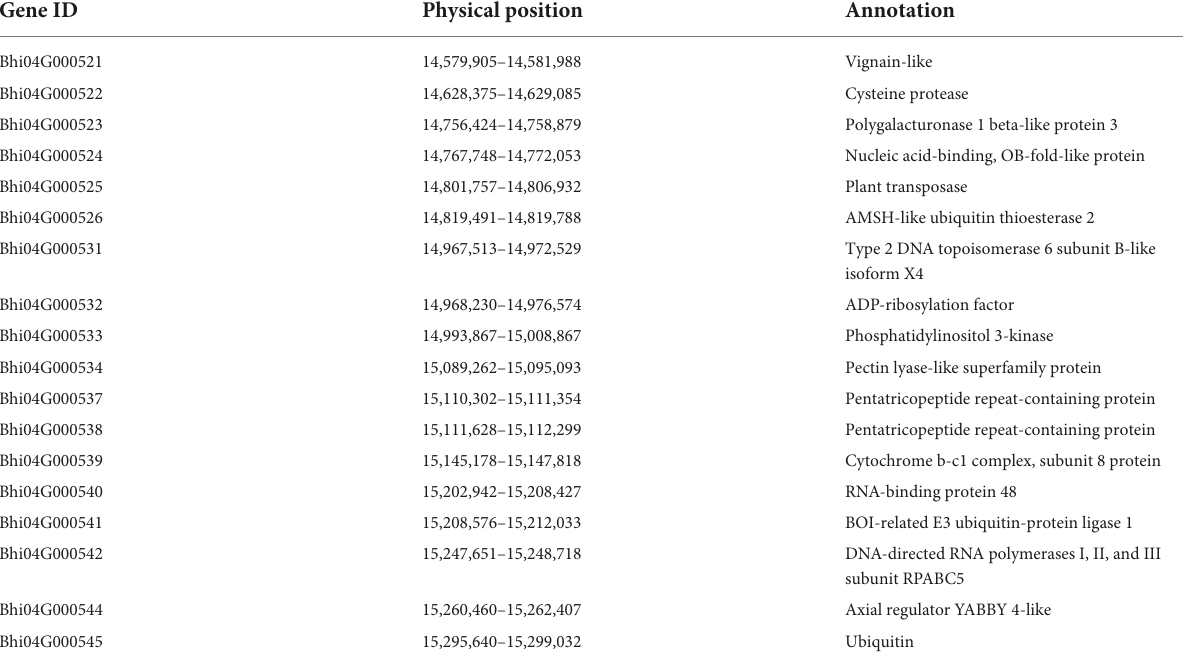
TABLE 2 Candidate annotated genes in the fine mapping